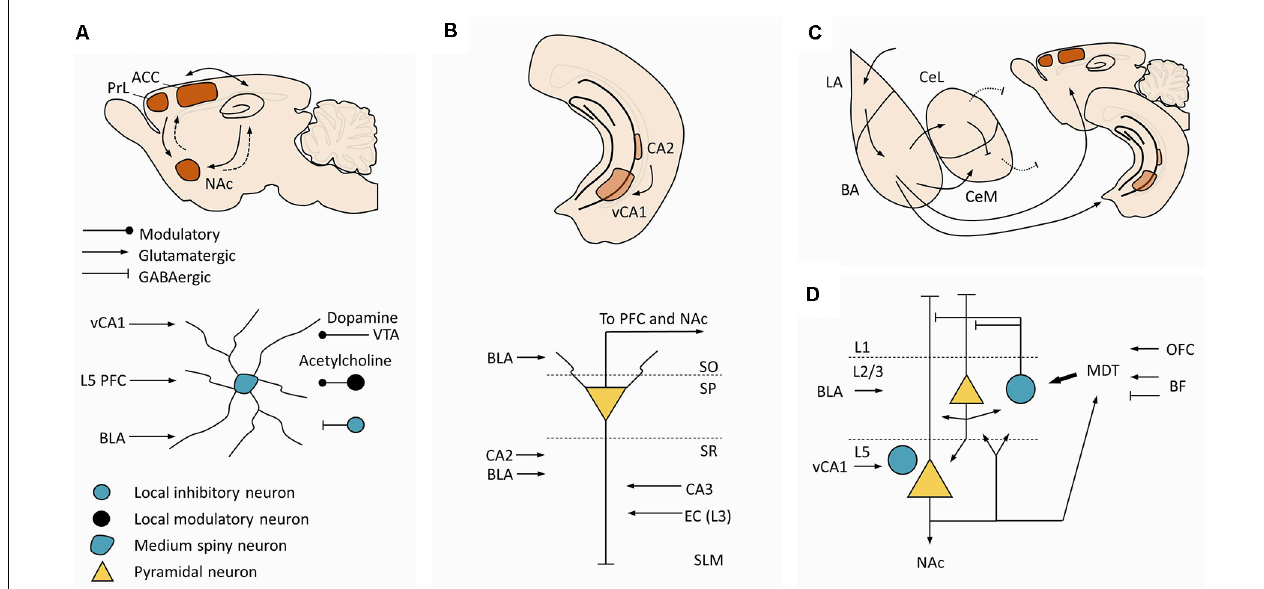
FIGURE 4 | Additional circuits to interrogate in future dominance studies. (A) Circuit of the NAc. Top. Macroscale circuit. The NAc receives monosynaptic projections (arrows) from PrL, ACC, and ventral hippocampus, projecting back to these regions through indirect connections (dashed arrows). Bottom. Canonical microcircuit in the NAc. Medium spiny neurons in NAc are the major targets of L5 pyramidal neurons from PrL and ACC, pointing to striatal circuits as a logical downstream target to expand current ACC and PrL hypotheses for social dominance. (B) Circuit in vCA1. Top. Macroscale circuit. Hippocampus anatomy highlighting the location of CA2 and vCA1. Bottom . Canonical microcircuit in ventral CA1, pyramidal neurons in vCA1 receive inputs from CA2, CA3 and EC, and project to the PFC and NAc. This microcircuit suggests an interplay between dominance mechanisms and the circuits regulating social memory. (C) Macroscale circuit in the amygdala. Amygdala anatomy highlighting the connectivity between LA, BA, CeL, and CeM, and the PFC and ventral hippocampus. Arrows represent excitatory projections, blunt lines represent inhibitory projections, and dashed lines represent inhibitory projections to brainstem regions responsible for aggression. (D) Microcircuit in the PFC. Panel (D) is similar to Figure 3A but here are included afferent projections from vCA1, which target mostly L5 prelimbic neurons (including L5 parvalbumin interneurons), afferent projections from the BLA, which target mostly L2 prelimbic neurons, and efferent projections to the NAc. Other prefrontal subareas receive vCA1 and BLA projections with different laminar distributions compared with the prelimbic region (not illustrated here). This panel summarizes candidate regions upstream and downstream to the prefrontal cortex that may be considered in future studies aiming at unraveling the circuitry supporting hierarchical behavior. Abbreviation: NAc, nucleus accumbens; PrL, prelimbic cortex; ACC, anterior cingulate cortex; PFC, prefrontal cortex; VTA, ventral tegmental area; vCA1, ventral CA1; EC, entorhinal cortex; SO, stratum oriens; SP, stratum pyramidale; SR, stratum radiatum; SLM, stratum lacunosum-moleculare; LA, lateral amygdala; BA, basal amygdala; BLA, basolateral amygdala; CeL, centrolateral amygdala; CeM, centromedial